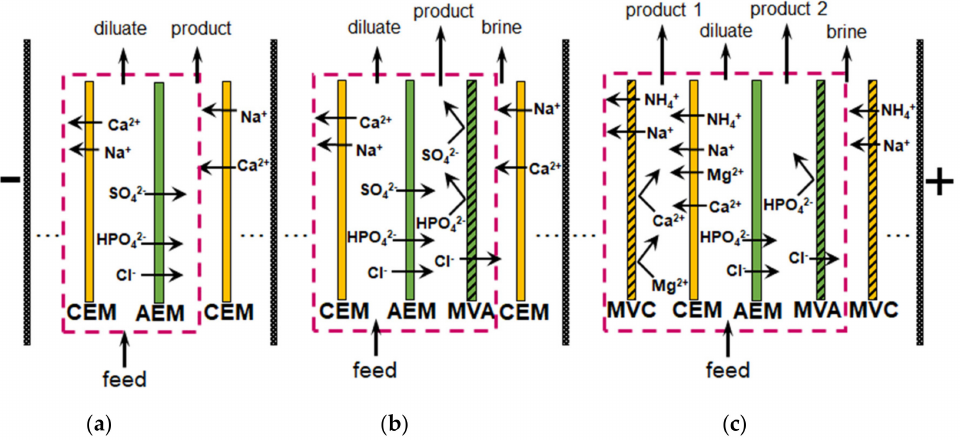
Figure 9. Scheme of repeating units of membrane stacks for conventional ED ( a ), anion selectrodialy- sis, aSED ( b ), and biselectrodialysis, bSED ( c ). Based on